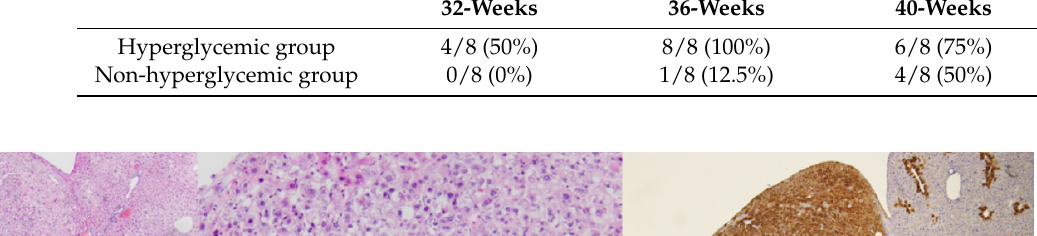
Table 2. Frequency of liver tumors in TSOD mice in experiment 1.